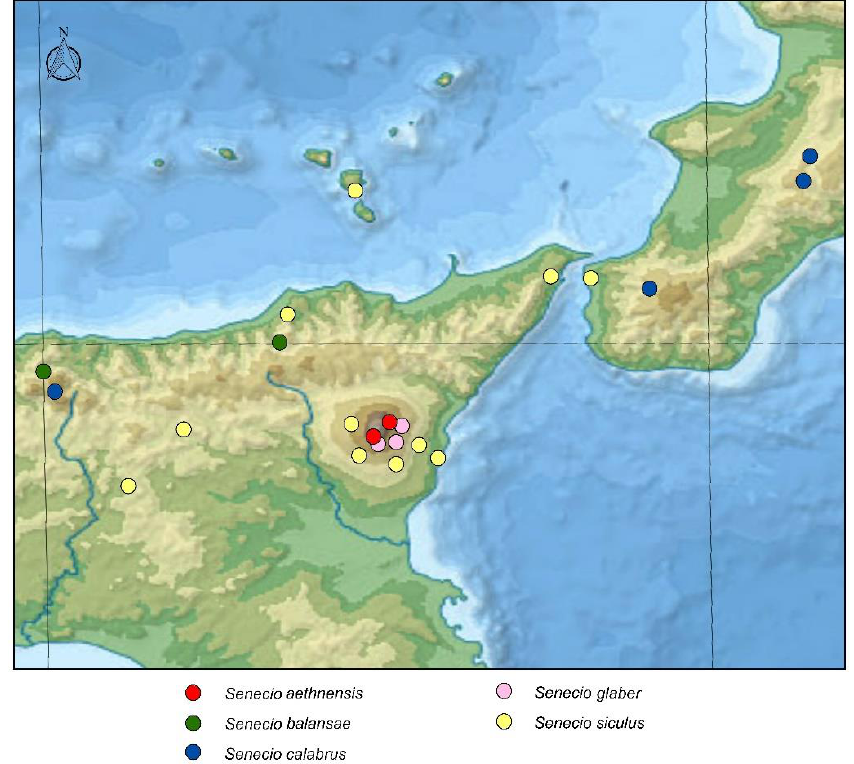
Figure 2. Detailed distribution map of the five species occurring across eastern Sicily and southern Calabria according to the studied herbarium specimens.